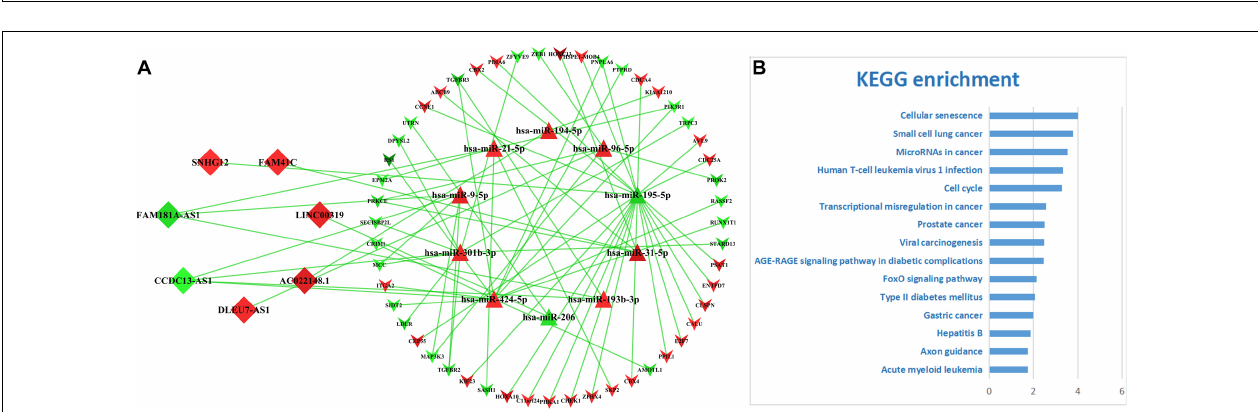
FIGURE 6 | Applicability of the lncRNA-based prognostic signature. (A–D) survival curves of the LUAD patients in different risk groups, stratified by four tumor stages [stage I (A) , stage II (B) , stage III (C) , and stage IV (D) ]. (E,F) Survival curves of the LUAD patients in different risk groups, stratified by two ages [age ≤ 60 (E) and age < 60 (F) ]. (G,H) Survival curves of the LUAD patients in different risk groups, stratified by gender [male (G) and female (H) ]. (I) Multivariate Cox regression with the lncRNA-based signature (risk score) and all available demographic and clinical factors included.